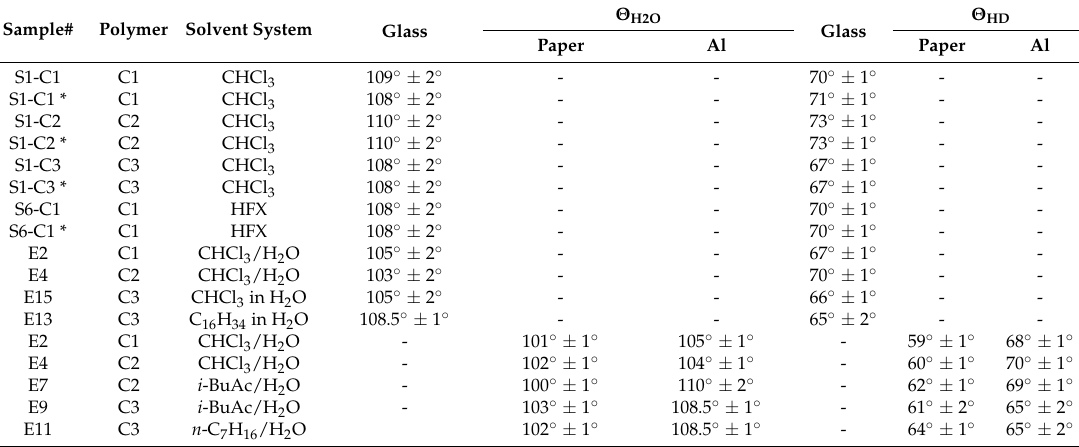
Table 5. Contact angle Θ values measured on different substrates covered with C1, C2, and C3 copolymers coated from solutions and